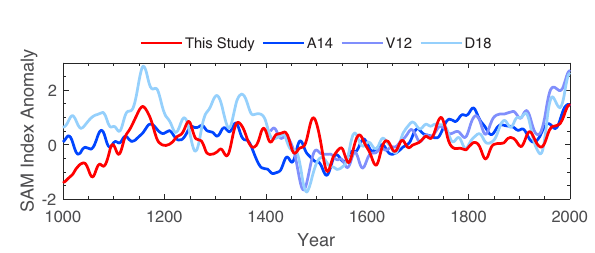
Fig. 5 | Reconstruction comparison. Comparison of Southern Annular Mode reconstructions over the last millennium. Previous reconstructions include A14 48 , V12 47 , and D18 49 . All reconstructions aresmoothedviaa 30-yearGaussian fi lter and normalized to the period 1400 – 1850